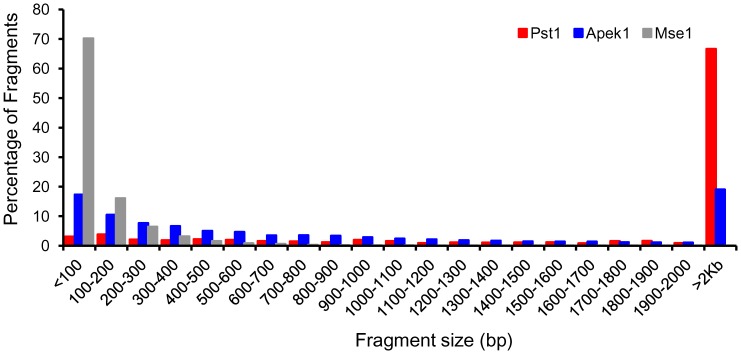

In silico analysis of restriction enzyme sites in the soybean genome.Fragment size distribution obtained by in silico digestion of soybean chromosome 5 with ApeK1, Pst1 and Mse1 restriction enzymes showing a higher percentage of ApeK1 fragments in a suitable range for genotyping by sequencing.